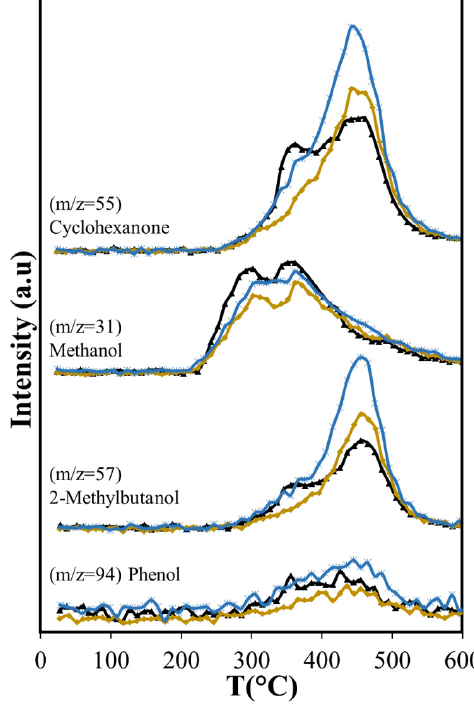
Figure 10. Effects of Aerosil 380 and MCM-41 over oxygenated compounds produced in catalytic pyrolysis of Agave salmiana bagasse. ( ASB, Aerosil 380, MCM-41).